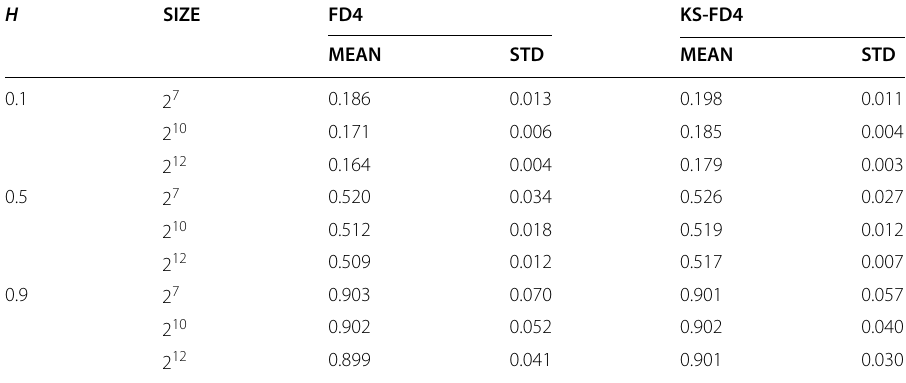
Table 3 Results of the Monte Carlo design to calculate the Hurst exponent with FD4 and KS‑FD4 for fractional Brownian motions with different H s and sizes